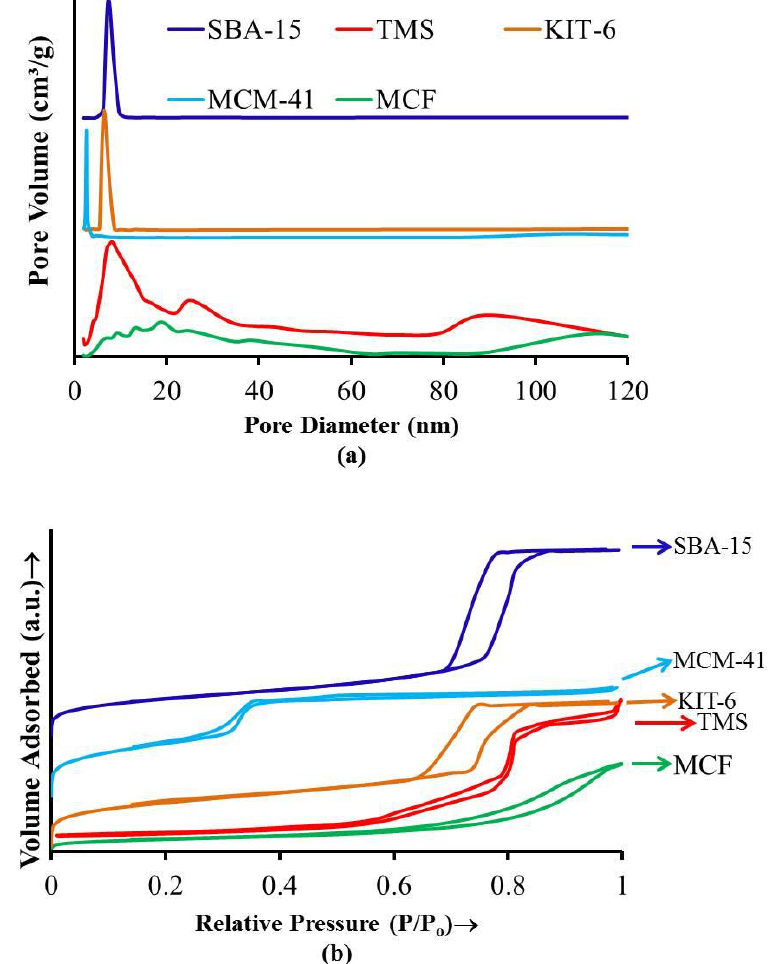
Figure 2. ( a ) Pore size distribution curves and ( b ) N 2 adsorption-desorption isotherms of the silica